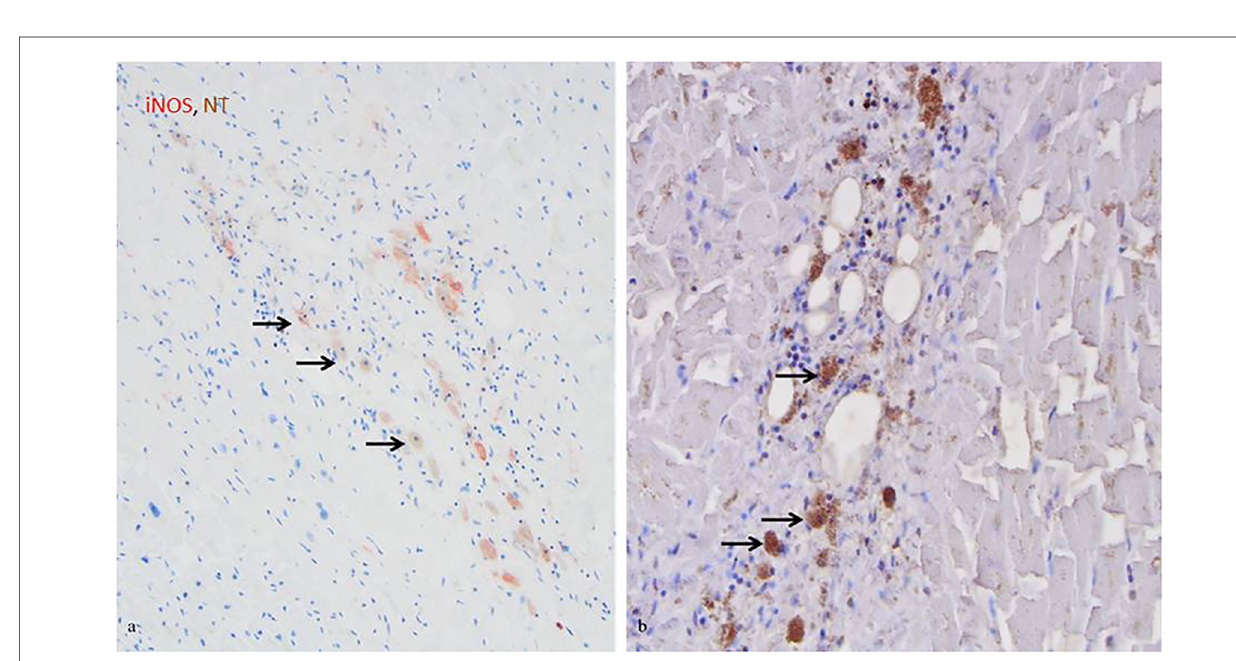
FIGURE 2 iNOS and NT co-expression by CD68+ macrophages in infarcted regions. ( A ) iNOS expression by macrophages in the acutely infarcted tissue, as indicated by the arrows (red, 20x). ( B ) NT expression by macrophages in the acutely infarcted tissue, as indicated by the arrows (brown, 20x). Cell nuclei were counterstained with